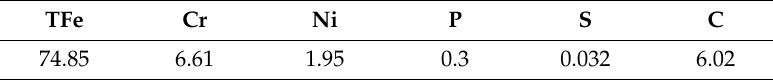
Figure 7. The macro-morphology of ferroalloy particles. Table 5. Chemical composition of ferroalloy (mass fraction, wt%).